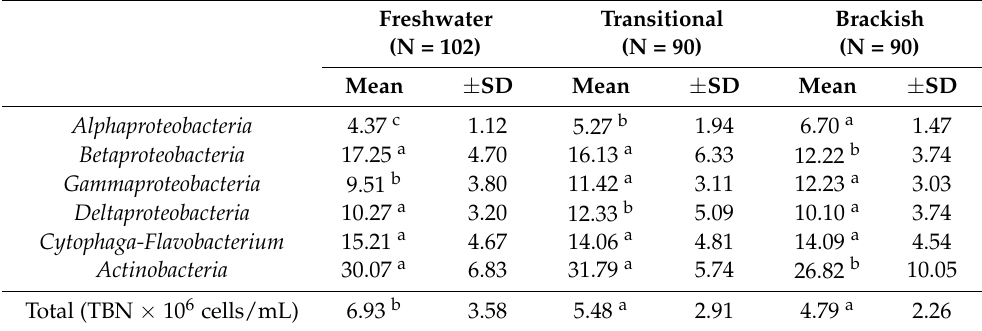
Table 4. Share of TBN (%) of groups of bacteria and total bacteria number (TBN × 10 6 cells/mL) in coastal lake types. Significant differences (one-way ANOVA, post hoc: Tukey’s HSD test; p < 0.05) are depicted with superscripts ( a , b , c